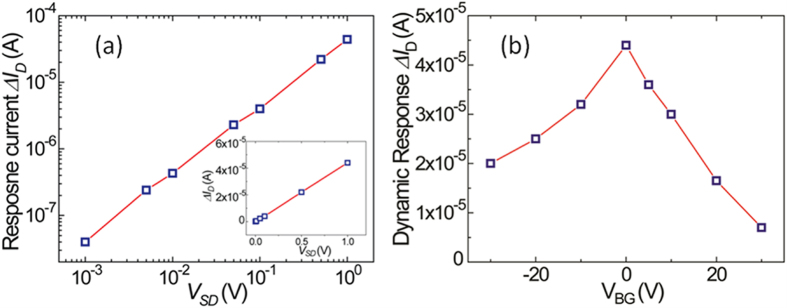
(a) Photoresponse current ΔID as function of applied source-drain voltage VSD at VBG = 0 V. The linear dependence confirms the photoconductor property. Inset shows the curve in linear scales. VBG = 0 V. (b) ΔID as function of back gate voltage VBG at VSD = 1 V. Laser intensity was kept at 198 mW/cm2 for both measurements.